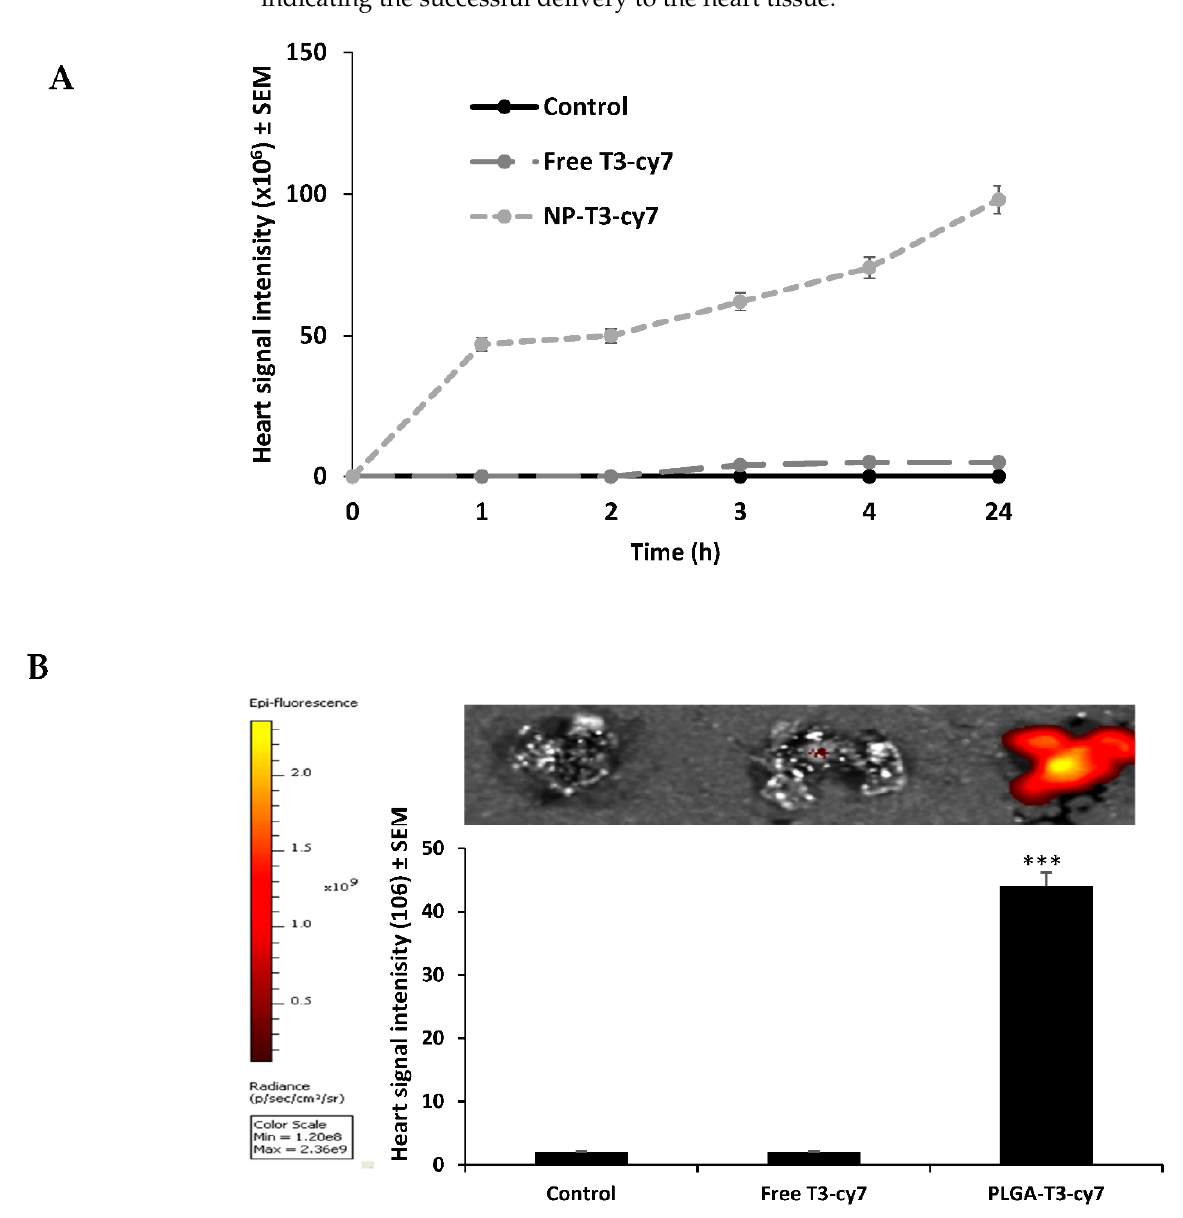
Figure 7. Free T3-Cy7 and PLGA-T3-Cy7 biodistribution in heart in mice (BALB/c) after injection of 300 uL subcutaneously. Cy7 signals detected with IVIS at excitation/emission maximum 750/776 nm wavelength. IVIS images taken to detect Cy7 signals during the following time: ( A ) Before injection, immediately, 1, 2, 3, 4 and 24 h. ( B ) Sacrificed at 24 h. Heart Cy7 signals imaged ex vivo, *** p < 0.001 versus control and T3-cy7.